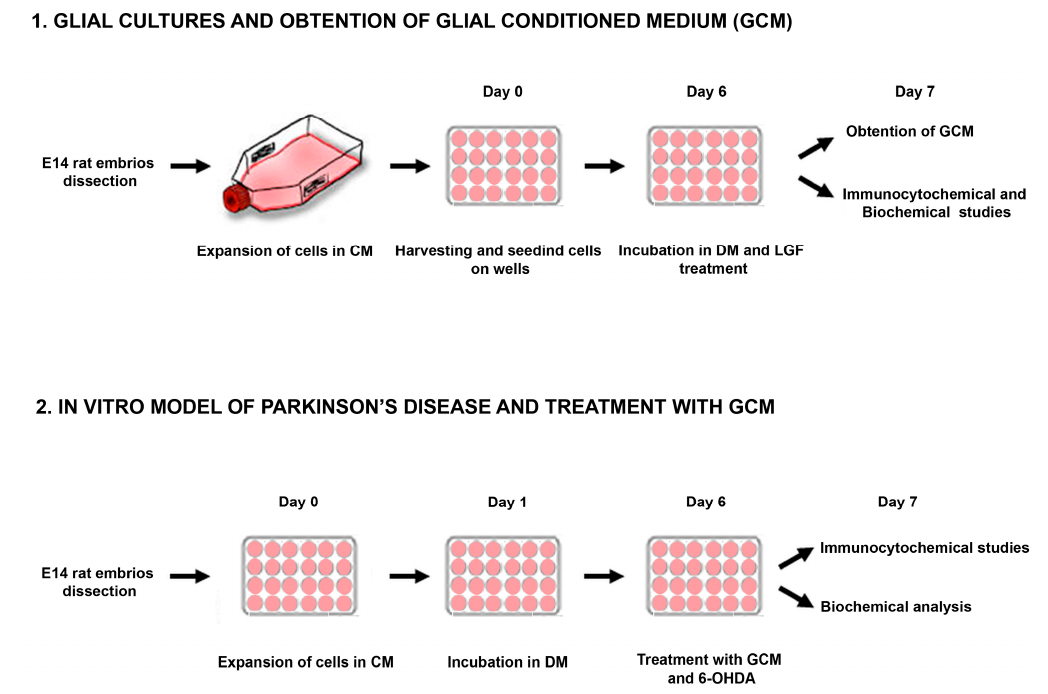
Figure 1. Experimental overview. Representative scheme showing the methodological procedure followed for obtention and treatment of glial cultures and mesencephalic neurons from E14 (embryos from Sprague Dawley rats of 14 days) rat mesencephalon. CM: complete medium; DM: defined medium; 6-OHDA: 6-hydroxy-dopamine.